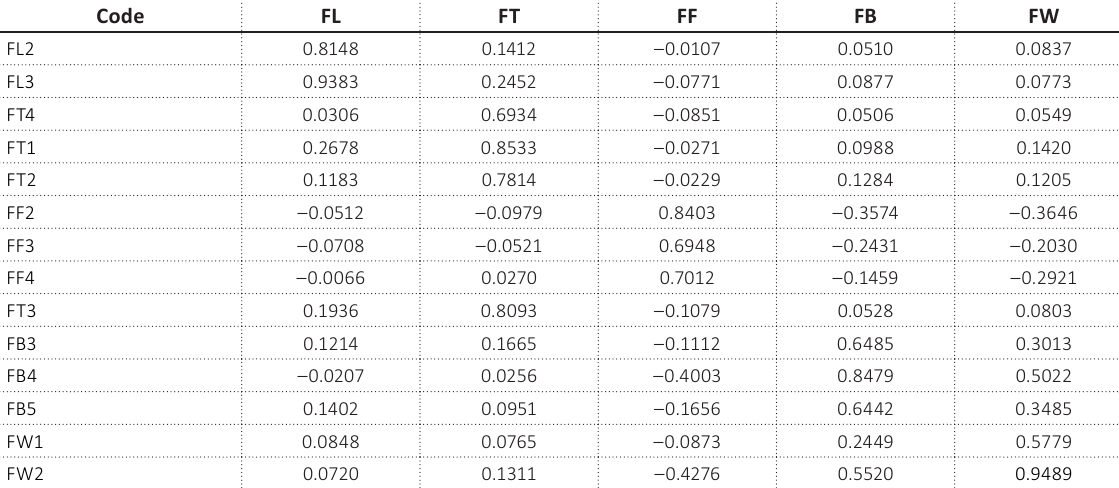
Table 4. Cross loadings of the indicators Code